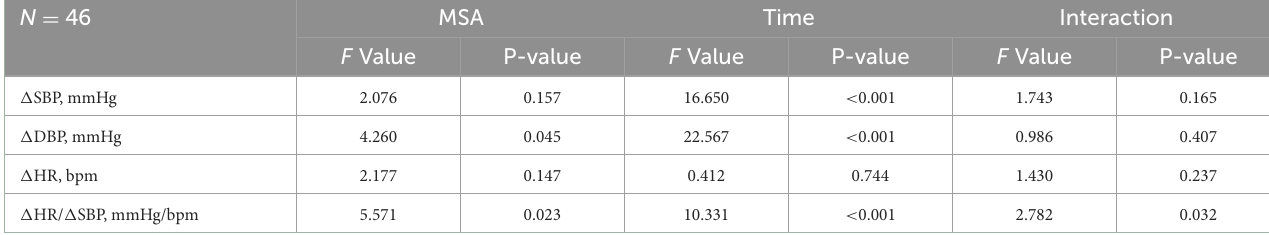
TABLE 2 Summary of repeated ANOVA for 1 SBP, 1 DBP, 1 HR, and 1 HR/ 1 SBP measurements across MSA and time points. N = 46